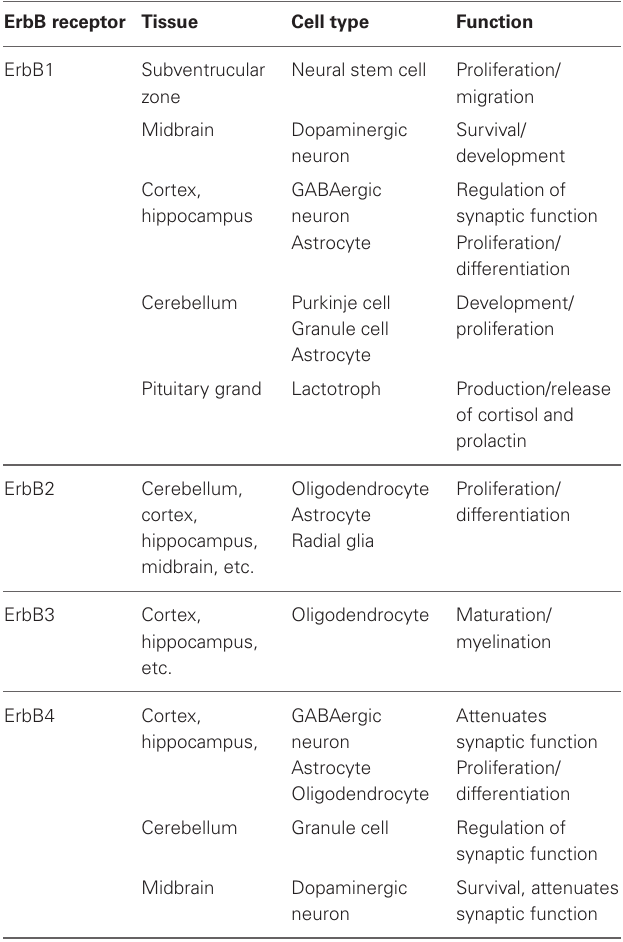
Table 2 | Brain distribution and functions of